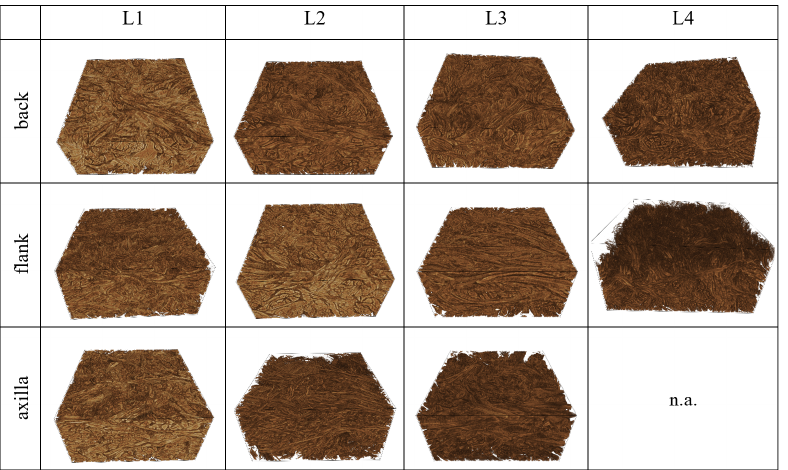
Figure 7. Renderings of (600 × 600 × 300 pixels corresponding to 2 × 2 × 1 mm 3 ) subvolumes of the reconstructed images of all 11 investigated leather